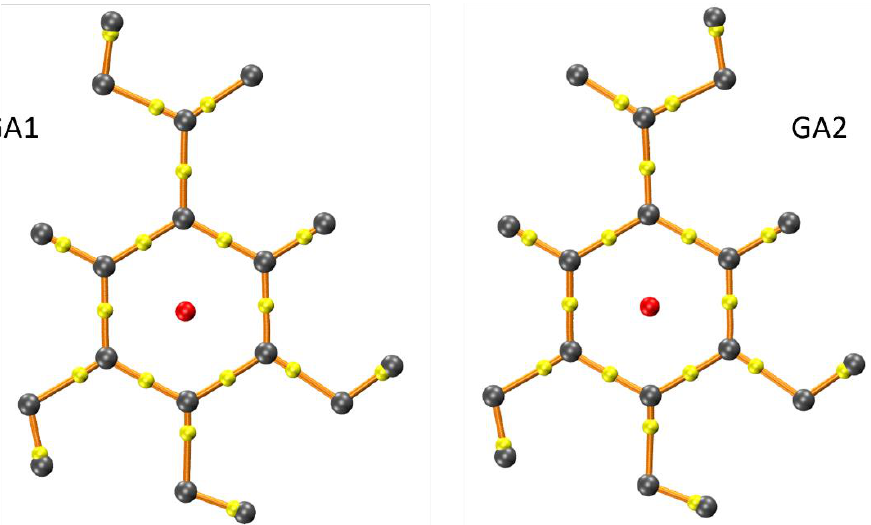
Figure 4. Molecular graph showing the results of the QTAIM analysis of conformers GA1 and GA2 of GA. Critical points are depicted with different colors, grey for the (3, − 3) maxima locating the atoms, yellow for the (3, − 1) bond critical points (BCP), and red for the (3,1) ring critical points (RCP). Bond paths (BP) are shown in orange. The equilibrium structures calculated at the B3LYP-D3/6- 311++G(2d,p) has been considered. As can be seen, there are no BCP locating possible hydrogen bonds between OH groups.